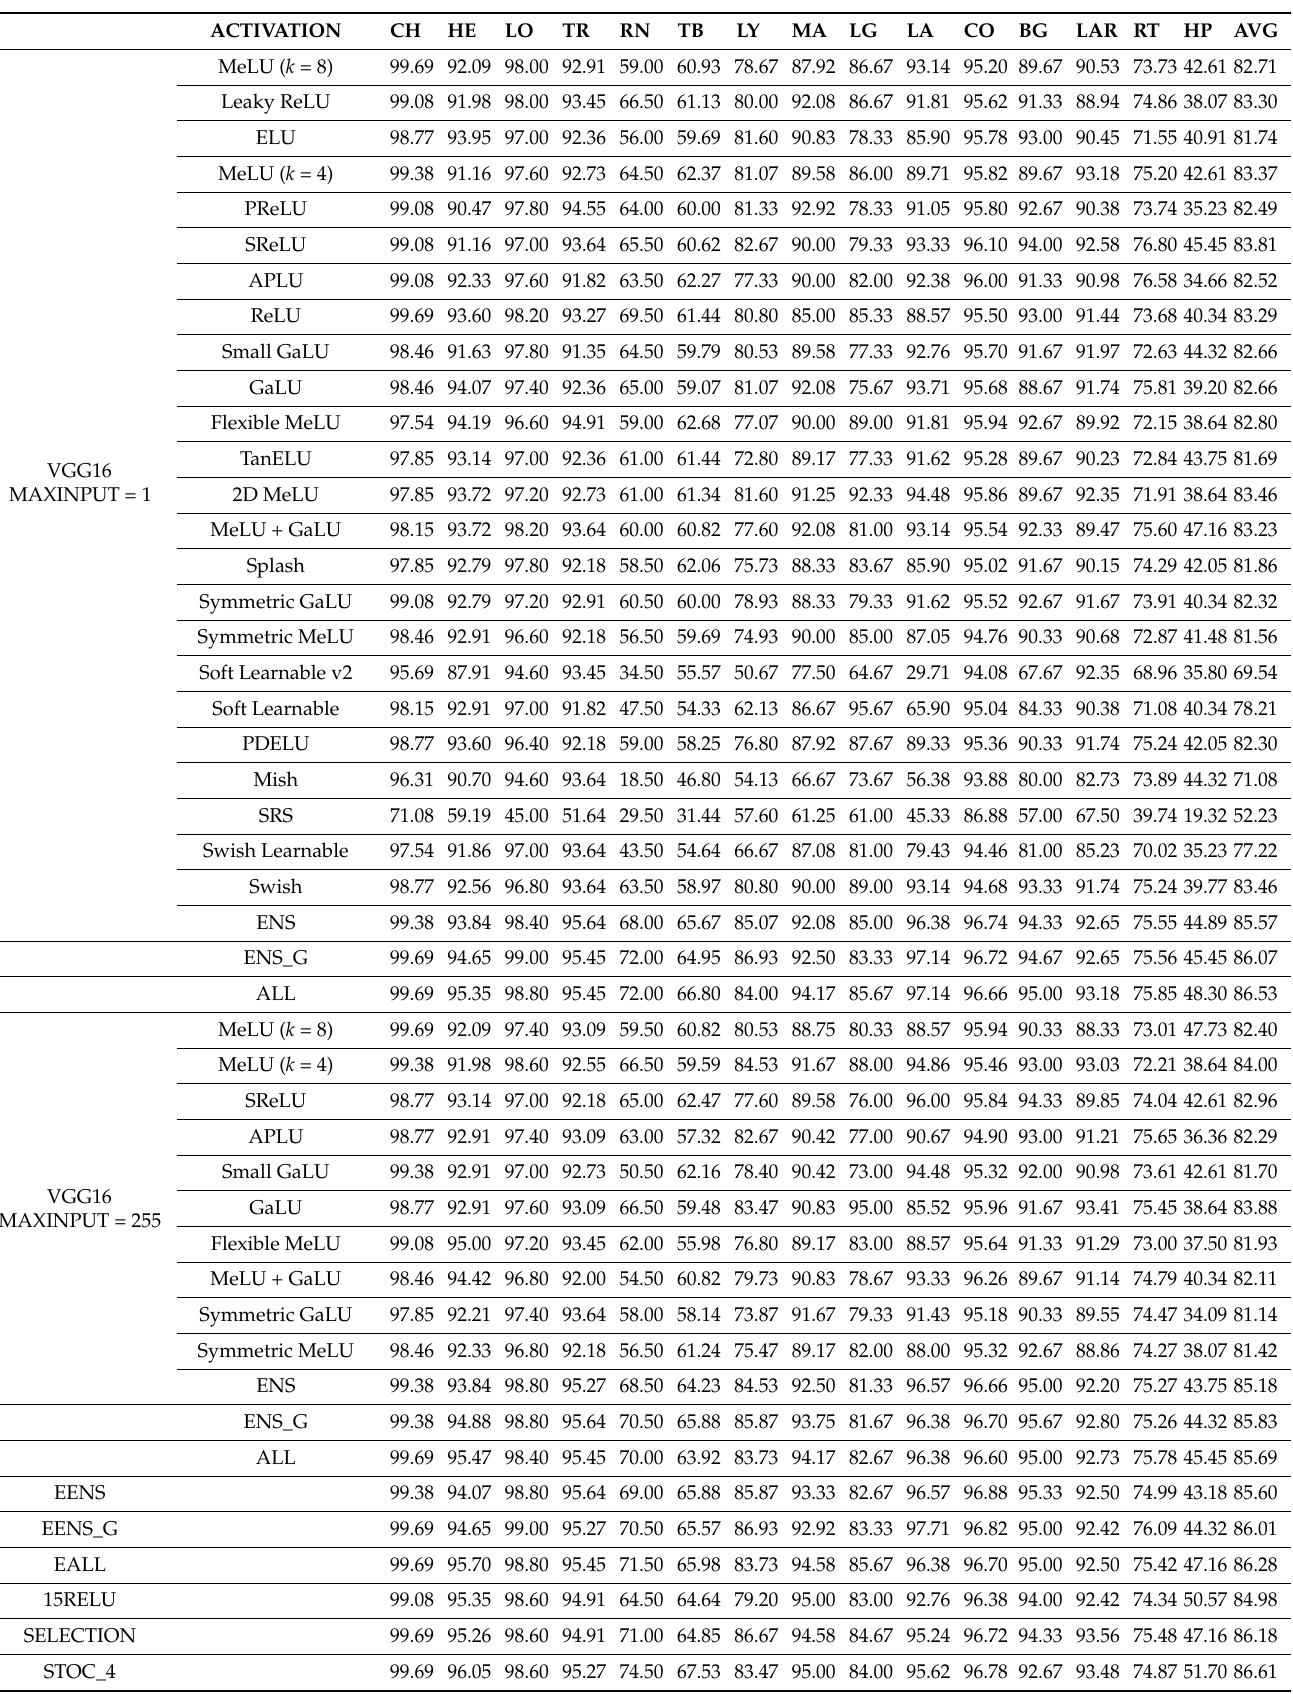
Table 5. Activation performance (accuracy) on